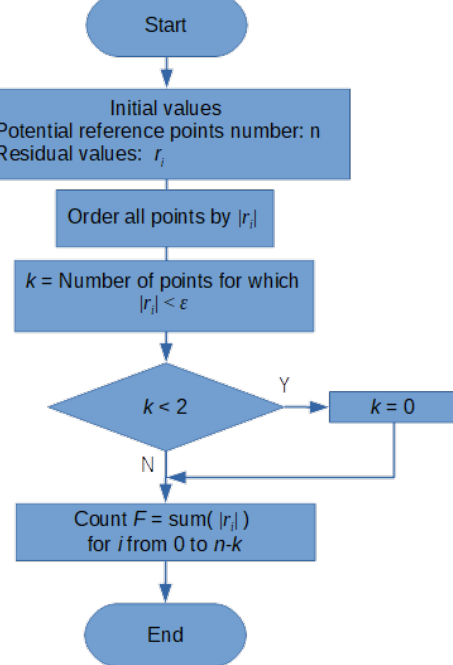
Figure 4. Flowchart of the objective function calculating algorithm.